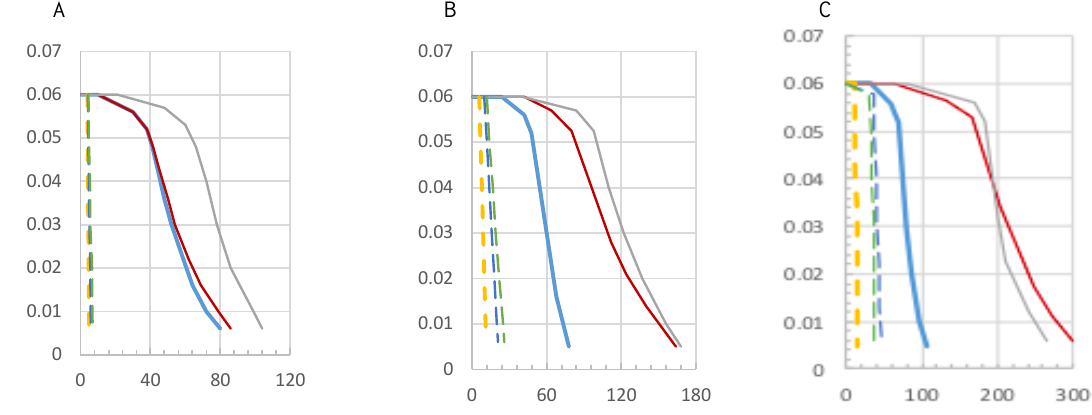
Fig. 5. Pollution Concentration on leeward and windward sides of the